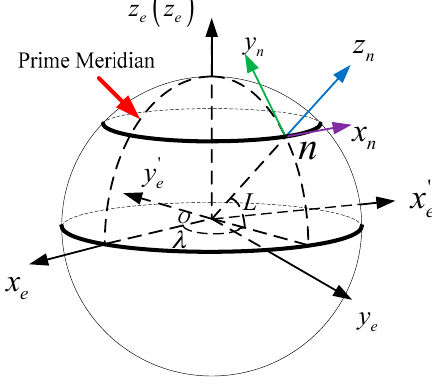
Figure A1. Curves of alignment errors.